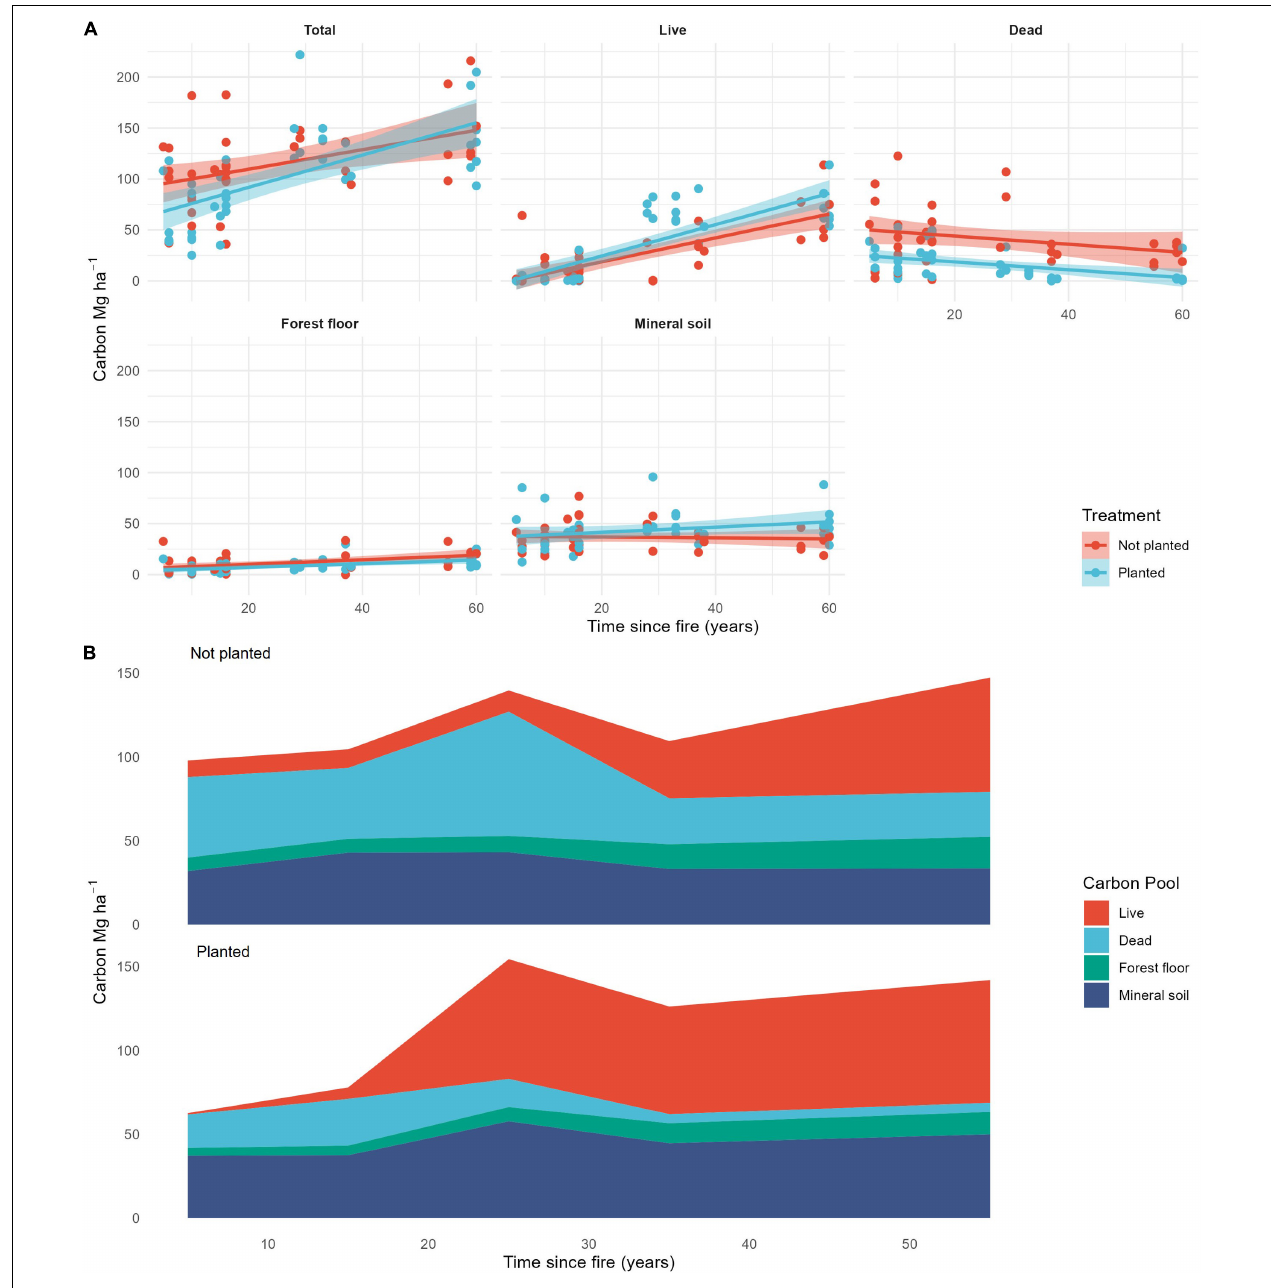
FIGURE 2 | (A) Carbon (Mg · ha − 1 ) over time since fire with and without tree planting across five carbon pools: Total, live, dead, forest floor, and mineral soil. (B) Cumulative contribution of four carbon pools (live, dead, forest floor, and mineral soil) to total carbon with and without tree planting, and over time since fire. Data are averaged across stands within planting treatments in 10-year time since fire bins ( < 11, 11–20, 21–30, 31–40, 51–60; no stands in 41–50 years